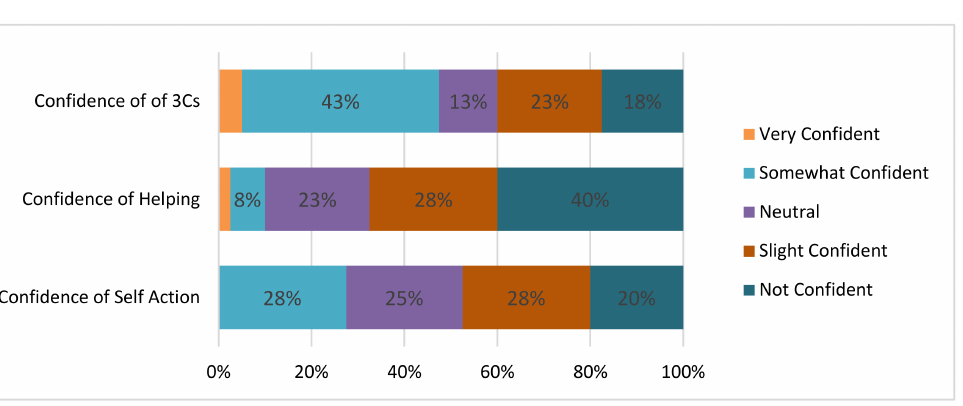
Figure 7. Confidence in recommended actions.